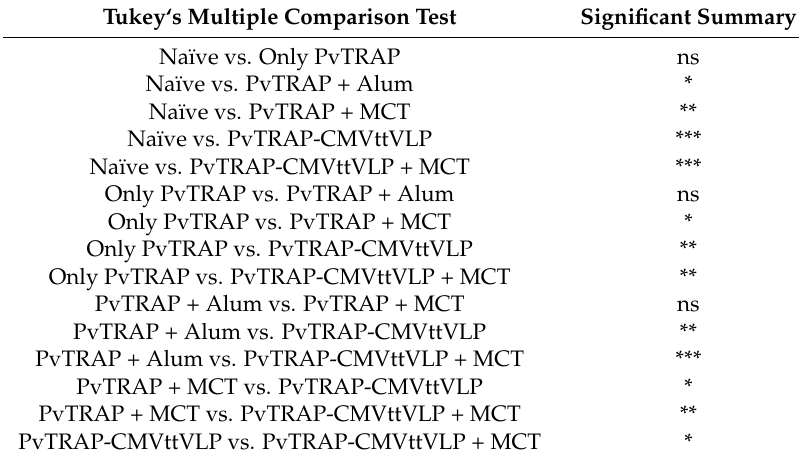
Table 1. Statistical analysis results of the challenge with P. berghei expressing P. vivax TRAP. As shown in this table, all groups vaccinated with protein plus adjuvant and/or VLP show significantly increased survival compared to the group vaccinated with PBS (naïve). However, when we compare naïve vs. only protein, there is no statistical difference. When comparing mice vaccinated with only protein with protein plus alum adjuvants, there was no statistical difference in survival, but if those groups are compared with MCT and or VLP, there is a significant difference in survival. The group vaccinated with PvTRAP-CMVttVLP + MCT adjuvant exhibits significantly better protection compared with all other groups. Data of six mice per group were analysed using GraphPad Prism software applied to assess the means of six groups by Tukey’s multiple comparison test of one-way ANOVA. ns = not significant, *** = p value < 0.0001; ** = p value < 0.001; * = p value <